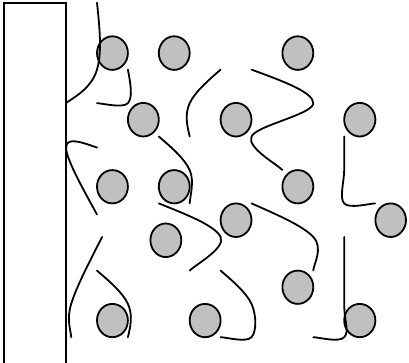
Figure 3. Schematic depiction of the multiplayer electrode. Circles=Hb, lines=SPAN, rectangle=GC electrode.